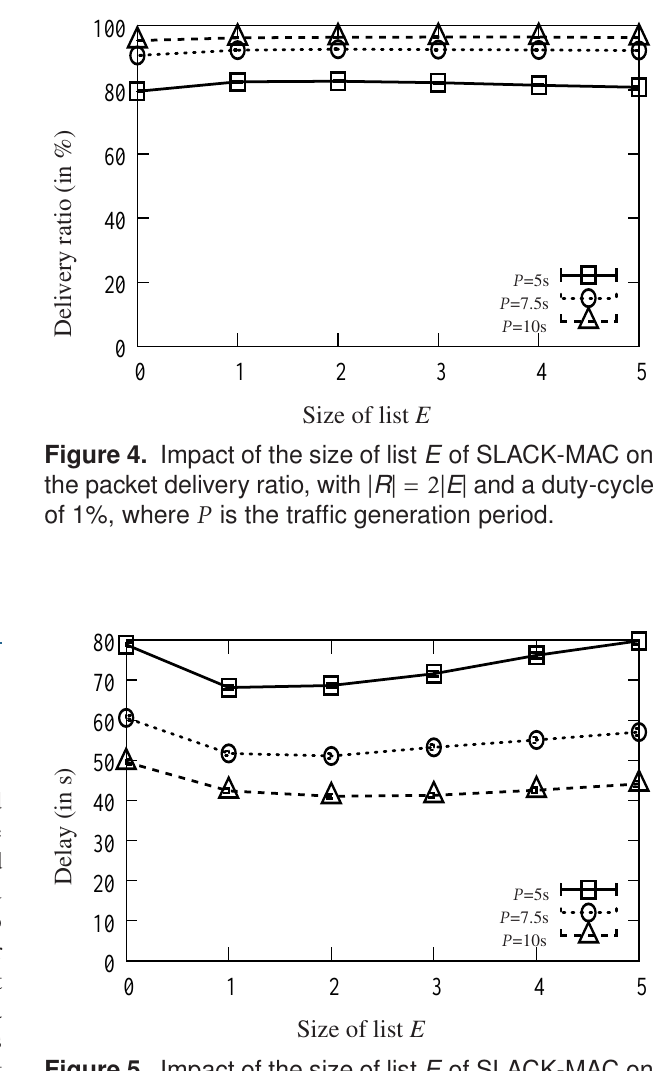
Figure 5. Impact of the size of list E of SLACK-MAC on the end-to-end delay, with | R | = 2 | E | and a duty-cycle of 1%, where P is the traffic generation